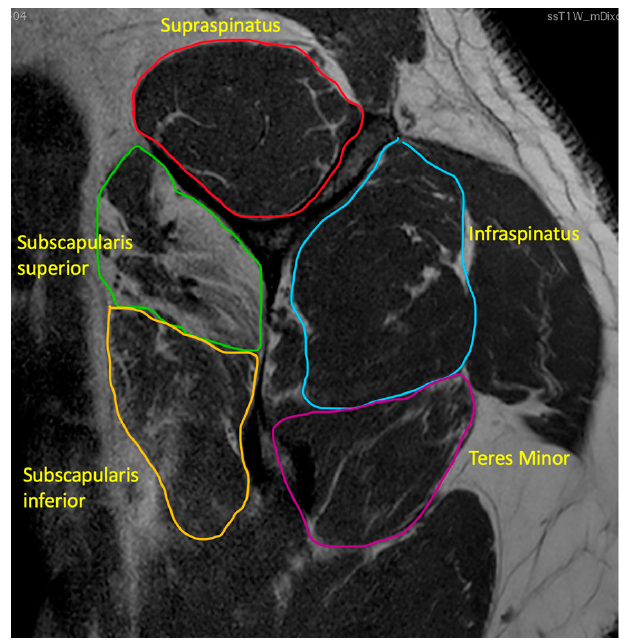
Figure 2. Goutallier Grade 4 subscapularis superior, Grade 3 subscapularis inferior, Grade 2 teres minor, Grade 2 infraspinatus, Grade 1 supraspinatus.